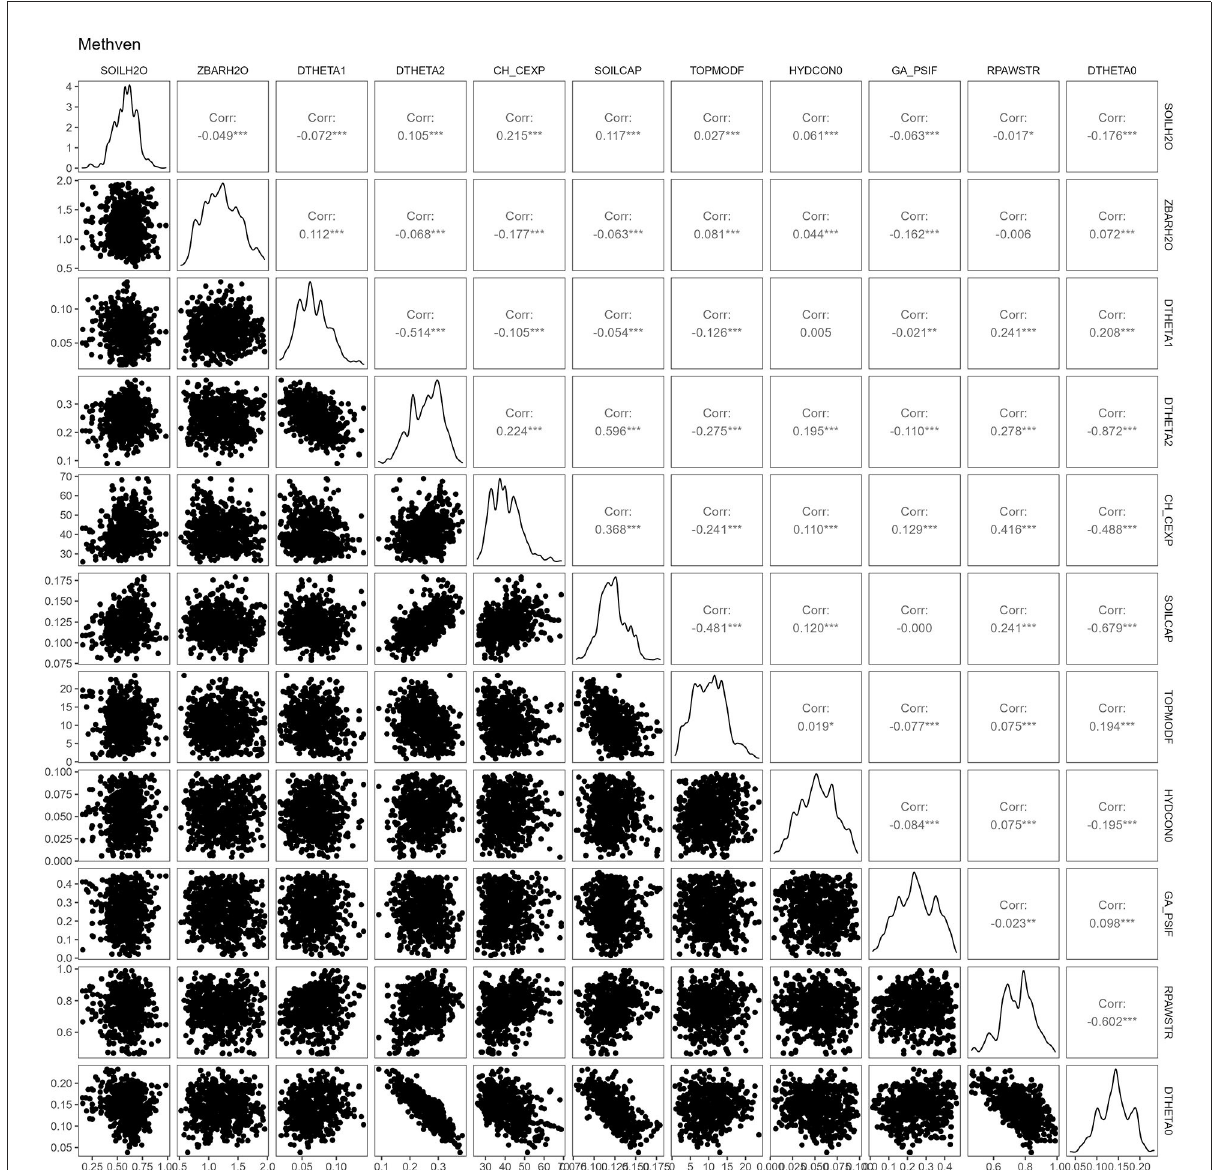
FIGUREA1 Correlation between parameters calibrated to Methven soil water content and drainage